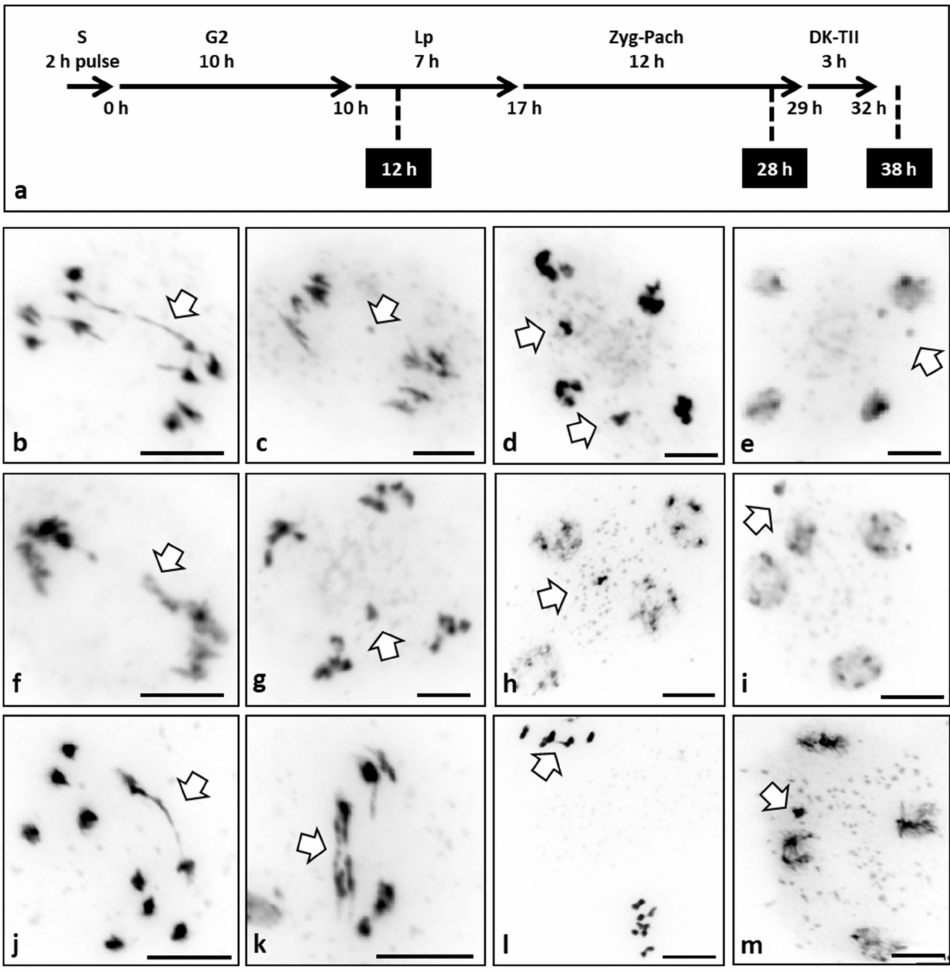
Figure 3. Meiotic stages of WT plants treated with different topoisomerase II inhibitors. ( a ) Plants were treated with TOPII inhibitors in two ways: (i) a 2 h pulse (P) or (ii) continuous (C). In both cases, flower buds were fixed at 12 h, 28 h, or 38 h after treatment. ( b – m ) Images of pollen mother cells at different stages of meiosis of the WT treated with TOPII inhibitors. ( b ) Anaphase I treated with merbarone 1 µ M (P) fixed at 38 h showing an anaphase bridge. ( c ) Anaphase I treated with merbarone 1 µ M (C) fixed at 38 h showing a chromosome fragment. ( d ) Anaphase II treated with merbarone 10 µ M (P) fixed at 38 h showing chromosome mis-segregation. ( e ) Telophase II treated with merbarone 1 µ M (C) fixed at 38 h showing micronuclei. ( f ) Anaphase I treated with etoposide 0.05 µ M (P) fixed at 38 h showing a broken anaphase bridge. ( g ) Anaphase II treated with etoposide 0.05 µ M (C) fixed at 38 h showing chromosome mis-segregation. ( h ) Telophase II treated with etoposide 0.05 µ M (P) fixed at 28 h showing a micronucleus. ( i ) Telophase II treated with etoposide 5 µ M (P) fixed at 28 h showing a micronucleus. ( j ) Anaphase I treated with ICRF-187 0.1 µ g/mL (P) fixed at 38 h showing an anaphase bridge. ( k ) Anaphase I treated with ICRF-187 100 µ g/mL (C) fixed at 28 h showing two anaphase bridges. ( l ) Metaphase II/anaphase II treated with ICRF-187 100 µ g/mL (C) fixed at 28 h showing an anaphase bridge. ( m ) Telophase II treated with ICRF-187 0.1 µ g/mL (P) fixed at 38 h showing a micronucleus. Arrows indicate errors in meiotic divisions. Scale bar 10 µ